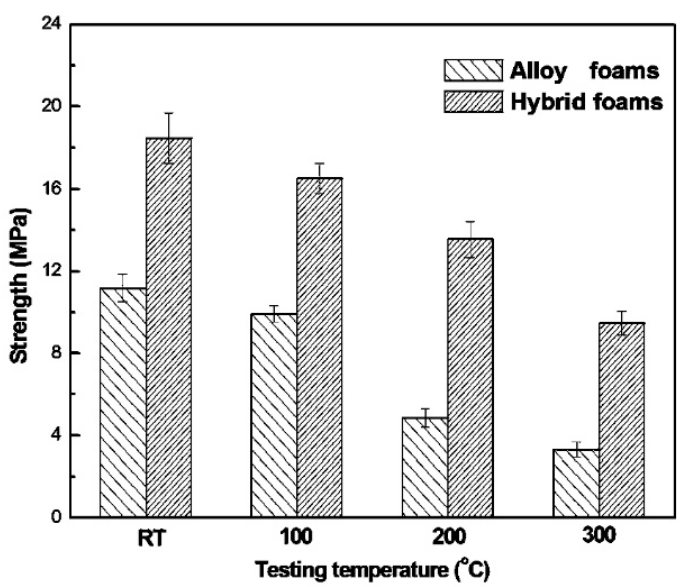
Figure 8. The compressive strengths of alloy foams and hybrid foams at different testing tempera- tures.